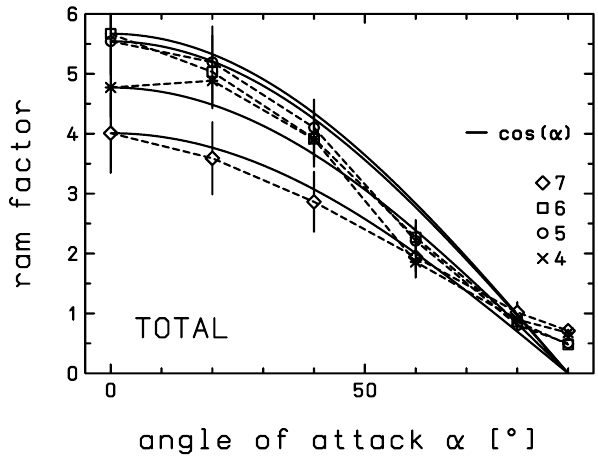
Fig. 3. As for Fig. 2 but for